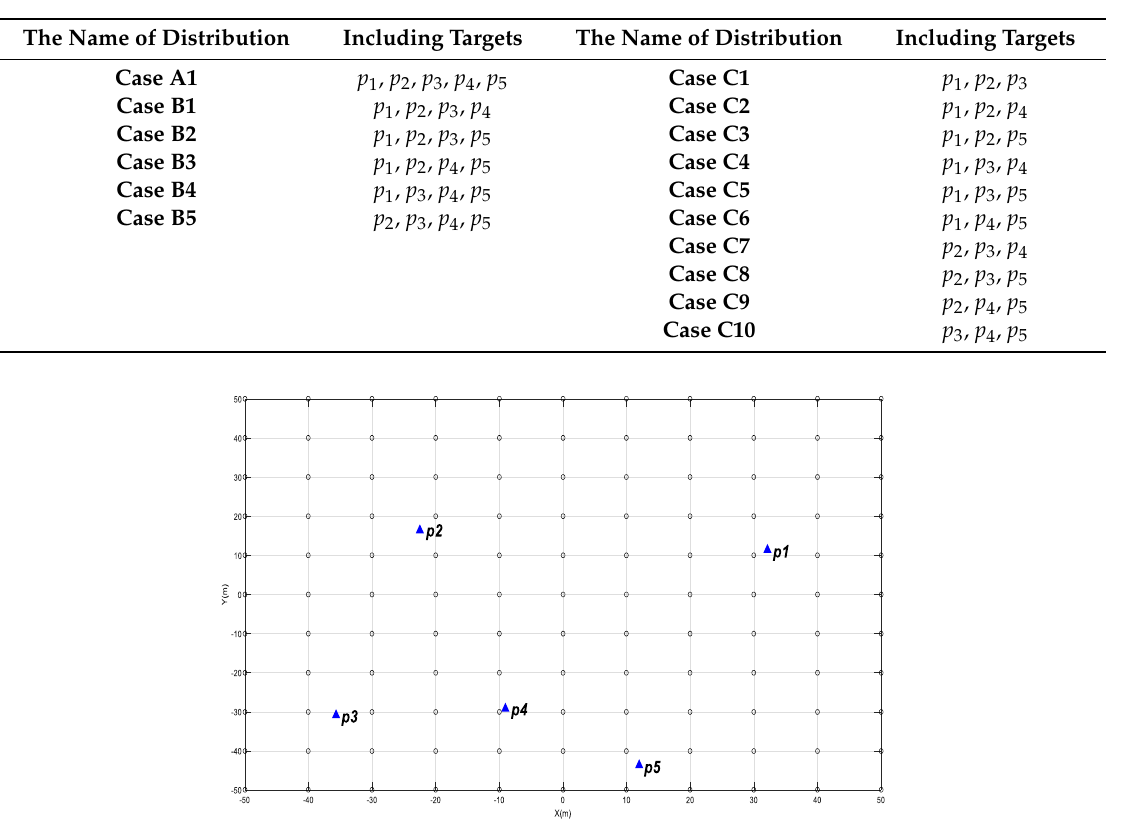
Table 1. Di ff erent target distributions.